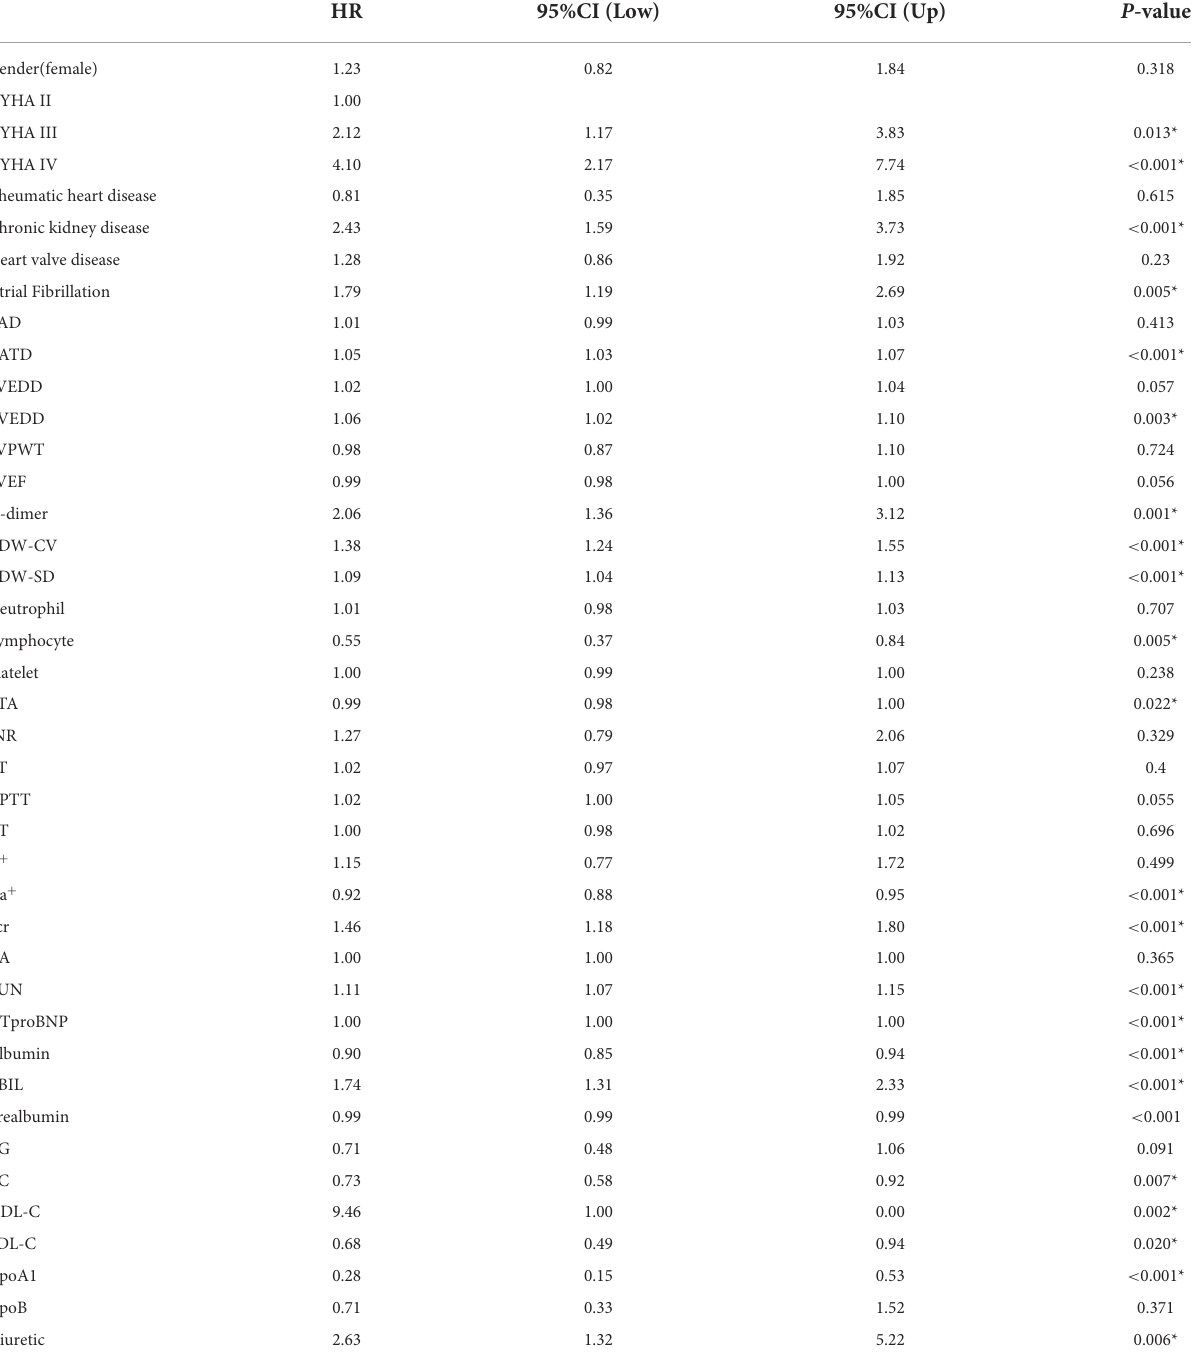
TABLE 2 Results of univariate COX regression